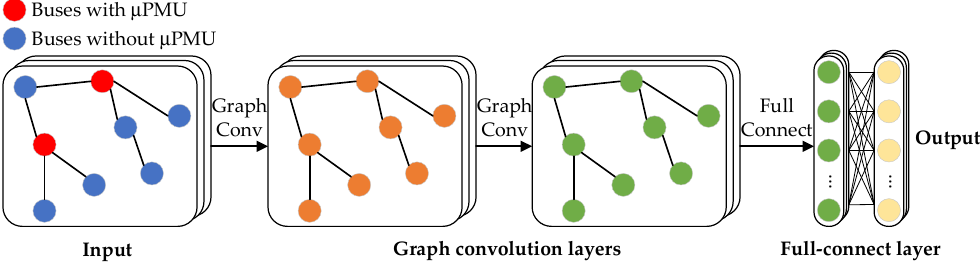
Figure 1. GCN-based SR model for feature reconstruction.